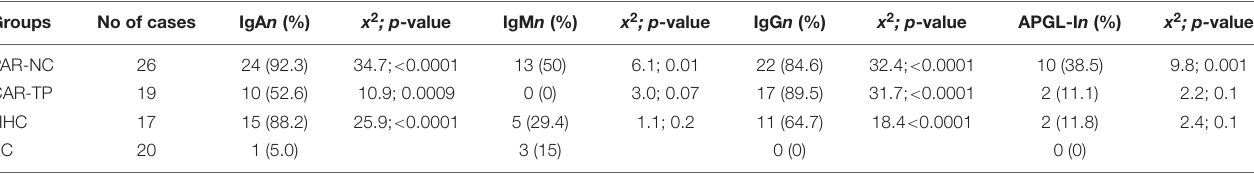
TABLE 3 | Positivity to antibodies against Mce1A protein and PGL-I in different groups of studies. Groups